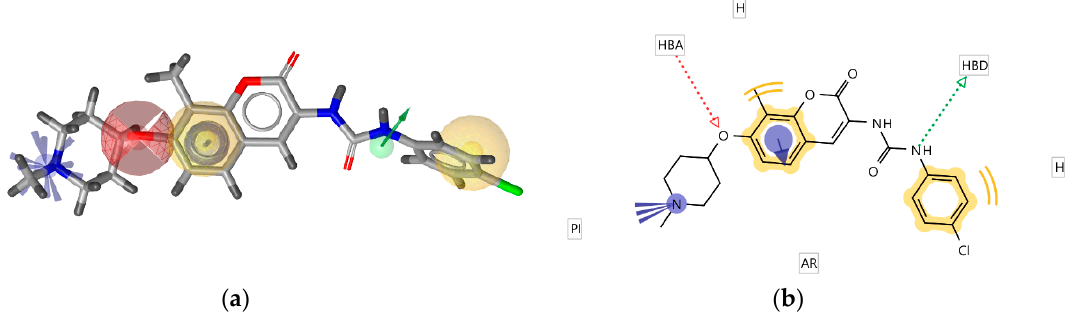
Figure 3. Alignment of compound 2 with the 3D-ligand-based pharmacophore model selected for virtual screening, ( a ) 3D-model and ( b ) 2D-projection. The model was derived using LigandScout 4.3 [29]. Exclusion volumes not displayed.